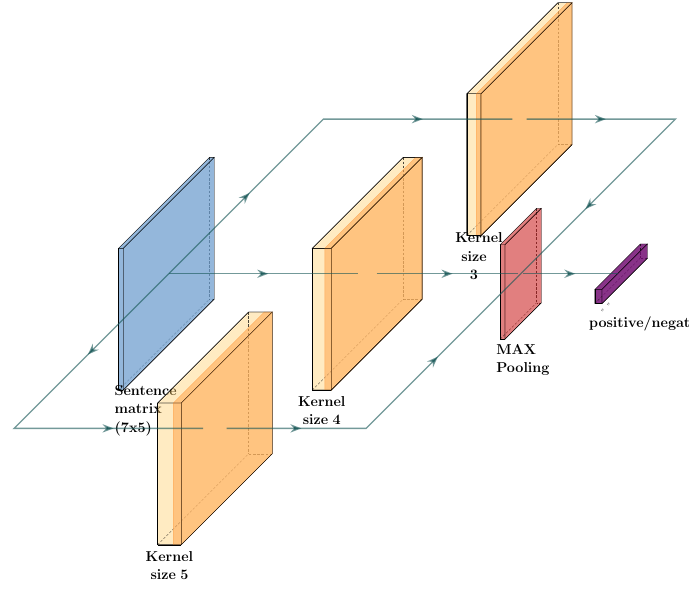
Figure 8. Proposed Convolution Neural Network (CNN) architecture.